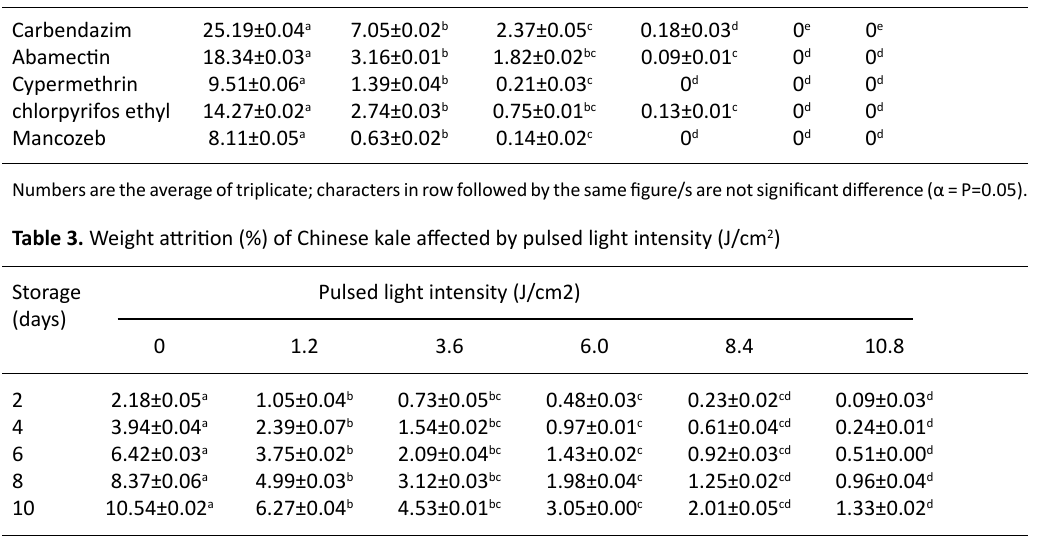
table 2. Pesticide residues (ppb) on Chinese kale affected by pulsed light intensity (J/cm 2 ) Pesticide residue Pulsed light intensity (J/cm 2 )